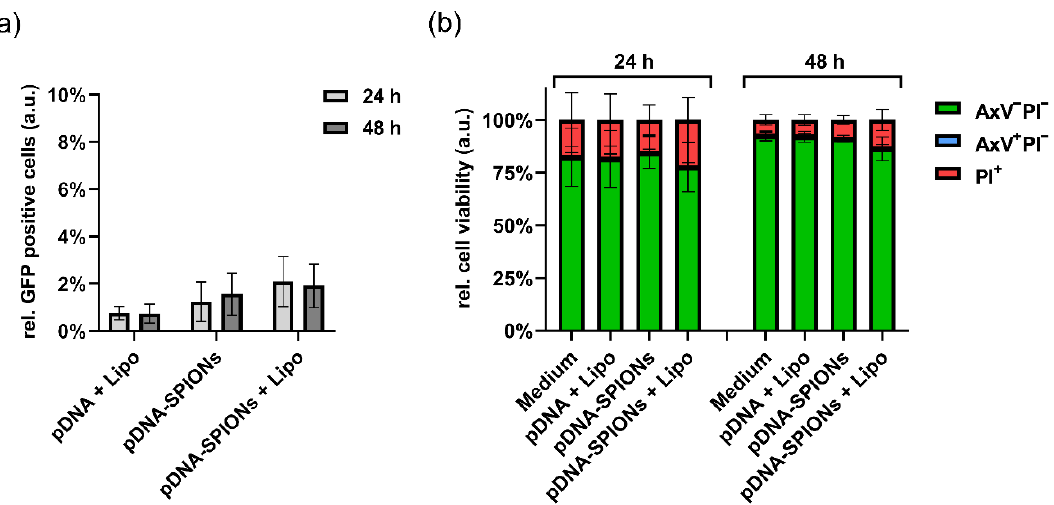
Figure A3. Transfection of 5 ng pDNA into A375-M cells using Lipo, pDNA-SPIONs and pDNA-SPIONs + Lipo. ( a ) Relative amount of GFP positive cells and ( b ) relative cell viability after incubation of the three different systems for 24 and 48 h. Statistically significant changes were calculated with two-way ANOVA.